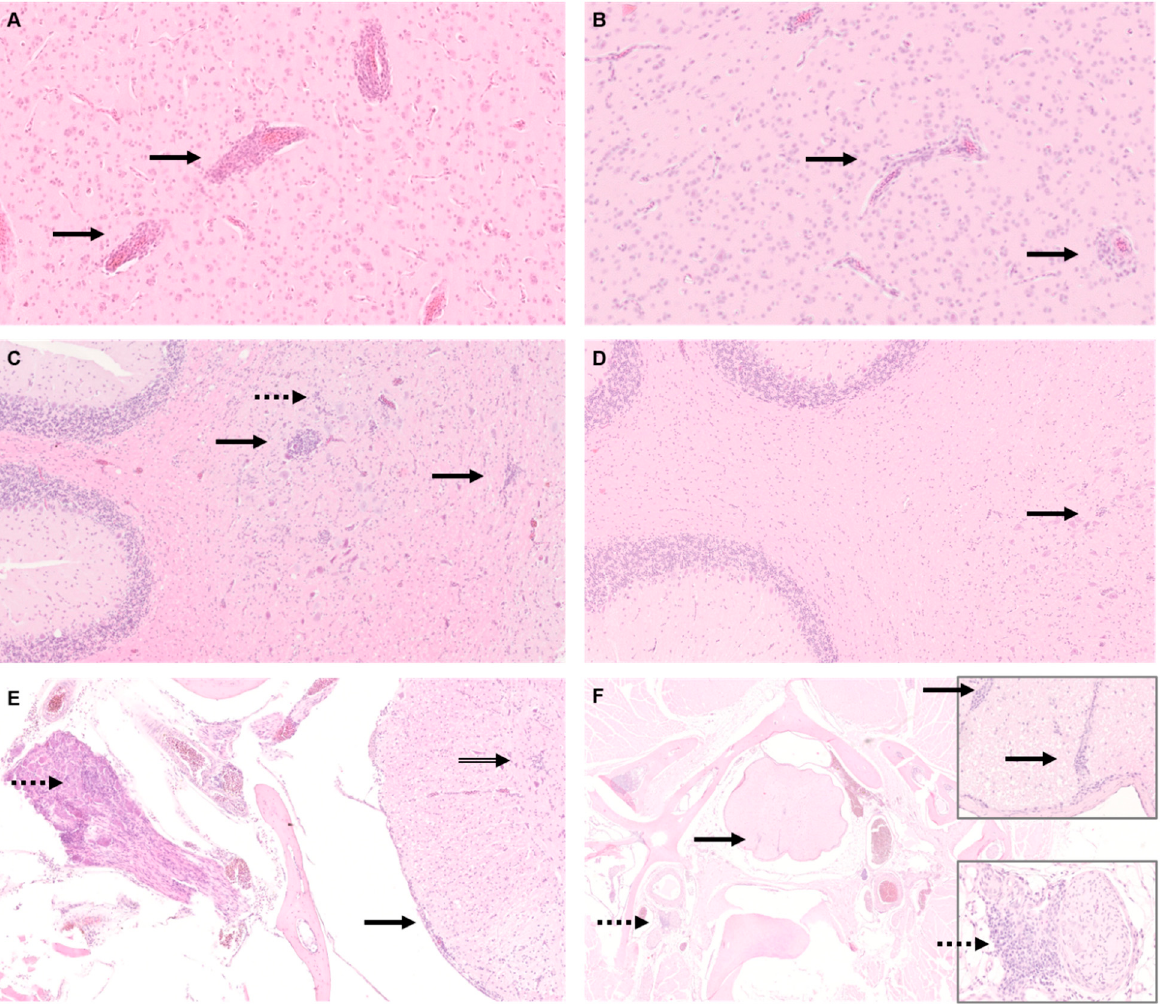
Figure 1. Histology of central nervous tissue of parrot bornavirus 4 (PaBV-4)-infected adult and juvenile cockatiels. ( A ) Cerebrum of adult cockatiel C 1,0. Severe non-purulent encephalitis with typical perivascular cuffs (arrow); original magnification × 200. ( B ) Cerebrum of juvenile cockatiel J 6. Moderate non-purulent encephalitis with typical perivascular cuffs (arrow) original magnification × 100. ( C ) Cerebellum of adult cockatiel D 1,0. Severe non-purulent encephalitis with perivascular cuffs (arrow) and gliosis (dashed arrow); original magnification × 100. ( D ) Cerebellum of juvenile cockatiel J6. Gliosis (arrow), no encephalitis is seen in the cerebellum in contrast to the cerebrum; original magnification × 100. ( E ) Spinal cord, spinal ganglion, and nerve of adult cockatiel D 1,0. Moderate non-purulent ganglioneuritis (dashed arrow) and moderate non-purulent meningomyelitis (arrow); original magnification × 100. ( F ) Spinal cord, spinal ganglion, and nerve of juvenile cockatiel J 6. Mild non-purulent perivascular myelitis (arrow) and severe non-purulent ganglioneuritis; original magnification × 25, magnification of inserts × 400. Hematoxylin and eosin staining (H&E).